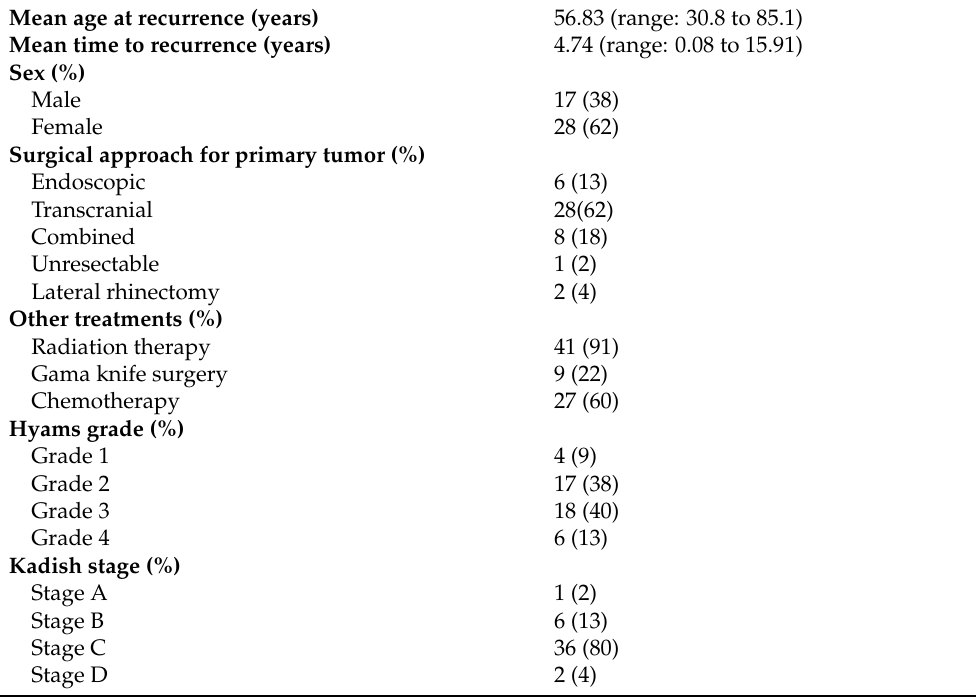
Table 1. Patient